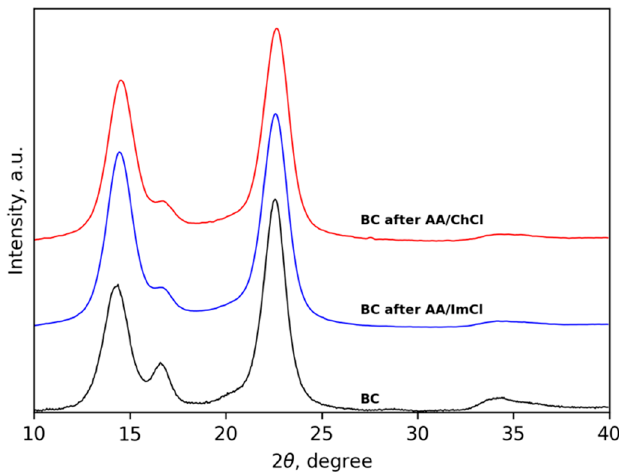
Figure 6. WAXD patterns of initial BC, BC after AA/ImCl and after AA/ChCl.